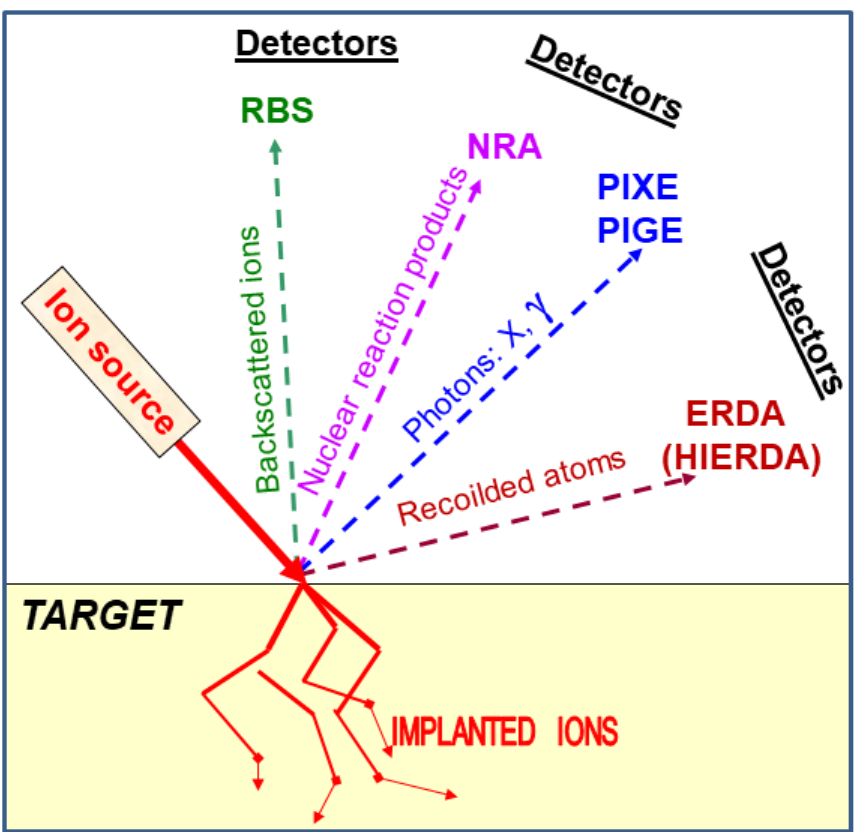
Figure 3. Ion-surface interactions: phenomena underlying different analysis methods. See text for details.